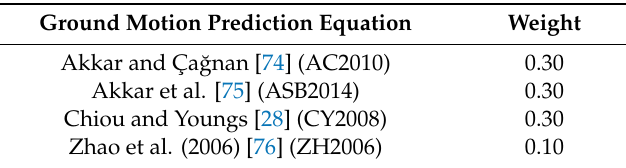
Table 5. The active shallow crustal GMPE logic tree used in the present study.